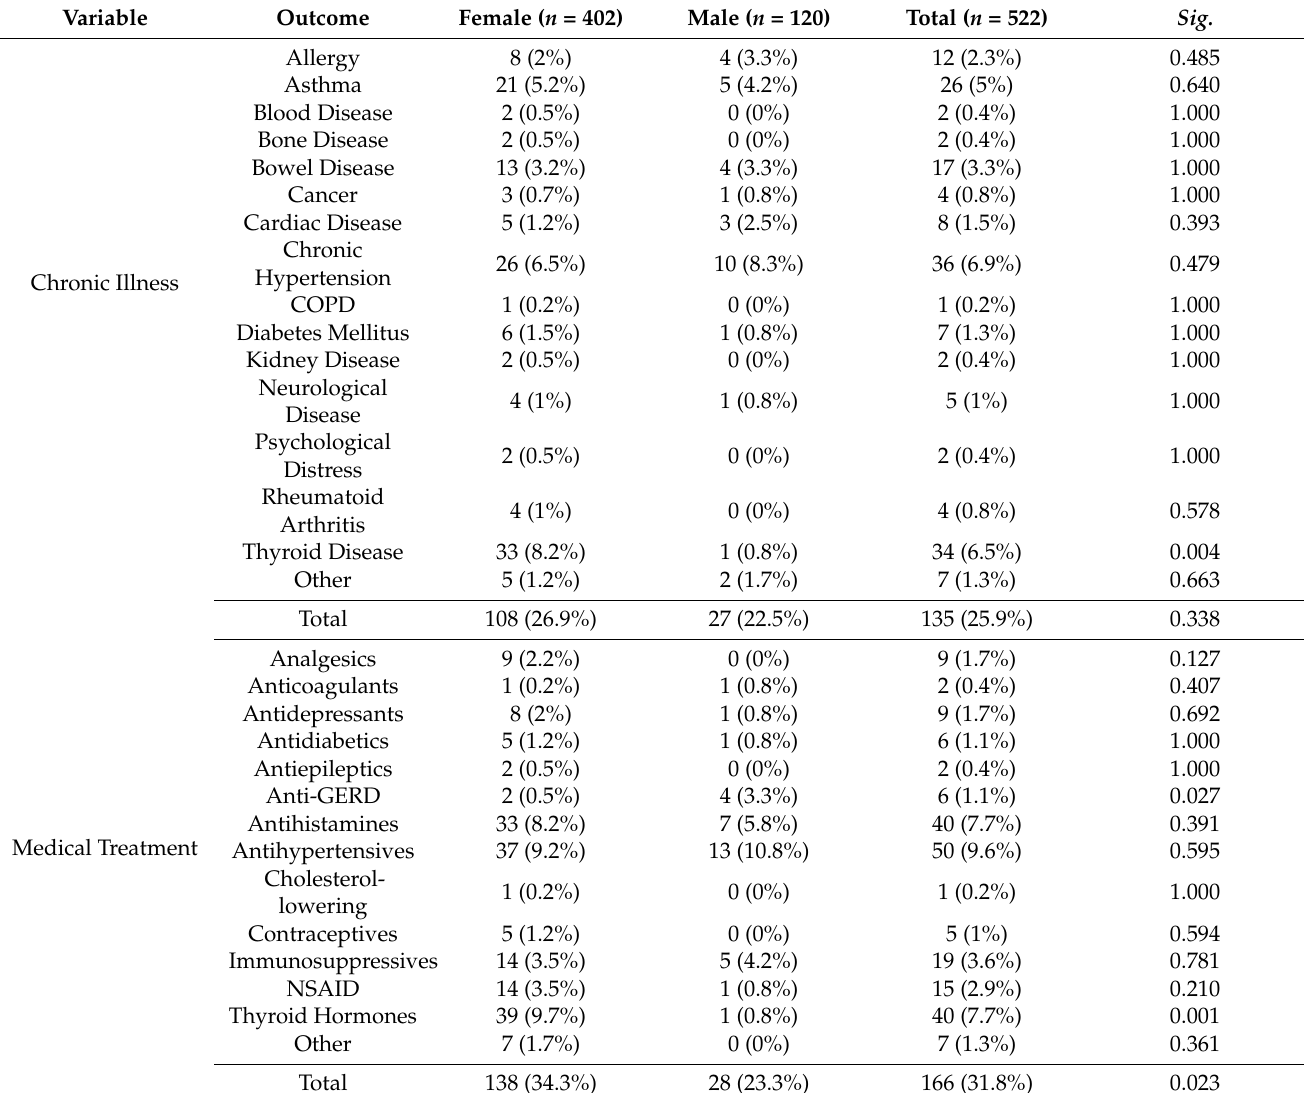
Table 2. Medical anamnesis of Slovak healthcare workers who received BNT162b2, February–March 2021 ( n = 522).